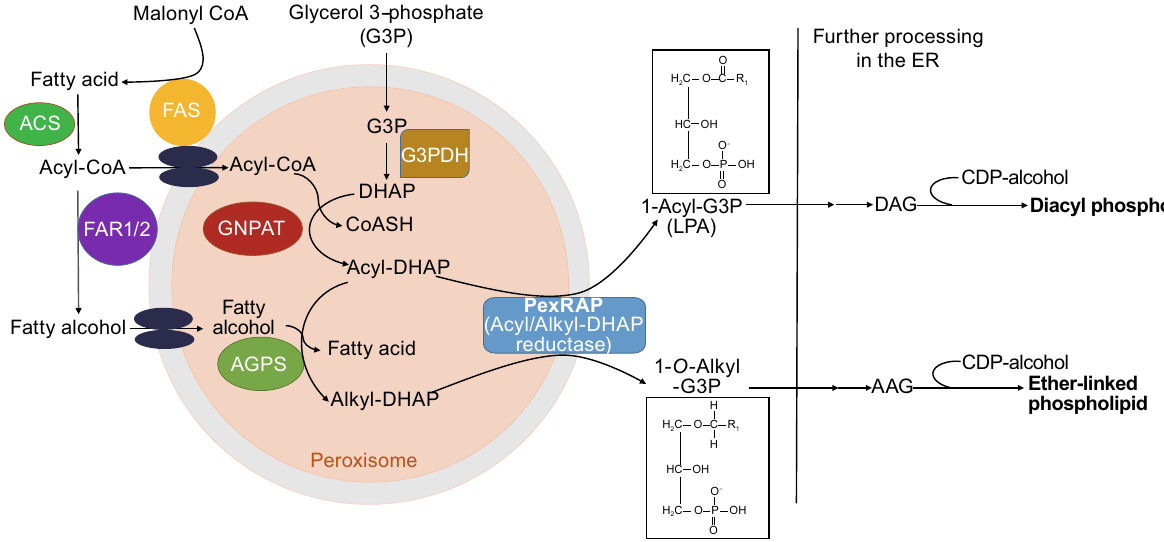
Figure 2. Acyl-DHAP pathway of ether lipid synthesis. This process begins in peroxisomes and is subsequently completed in the ER. The pathway utilizes dihydroxyacetone phosphate (DHAP) generated by glycerol 3-phosphate dehydrogenase (G3PDH)- mediated dehydrogenation of G3P as the substrate for ether lipid synthesis. Fatty acid synthase (FAS)-mediated de novo lipogenesis generates fatty acyl-CoA that is utilized by glyceronephosphate O-acyltransferase (GNPAT) or reduced to a fatty alcohol by a fatty acyl-CoA reductase (FAR1 or FAR2) to later be catalyzed by alkylglycerone phosphate synthase (AGPS), forming the ether bond and exchanging the acyl chain for an alkyl group. PexRAP (an acyl/alkyl DHAP reductase) then catalyzes the fi nal peroxisomal step, generating the ether lipid precursors, 1- O -alkyl-G3P (AGP) or the diacyl phospholipid precursor lysophosphatidic acid (LPA). The completion of phospholipid synthesis occurs in the ER. This includes acylation of the glycerol backbone at the sn-2 position, converting LPA to diacylglycerol (DAG) and AGP to alkyl-acylglycerol (AAG), as well as addition of a cytidine diphosphate-alcohol head group (such as CDP-choline or CDP-ethanolamine) at the sn-3 position to form the mature peroxisomal membrane. Glyceronephosphate O-acyltrans- partially localized to the peroxisomes, where it interacts with ferase (GNPAT), a peroxisomal matrix protein, uses a long various peroxisomal proteins (Hillebrand et al., 2012; Lodhi chain acyl-CoA to acylate DHAP at the sn-1 position. The et al., 2012; Cader et al., 2016). In order to be used for ether next peroxisomal step is catalyzed by alkylglycerone phos- lipid synthesis, fatty acids are fi rst activated to fatty acyl- phate synthase (AGPS) and results in the formation of the CoAs by an acyl-CoA synthetase (ACS) associated with the